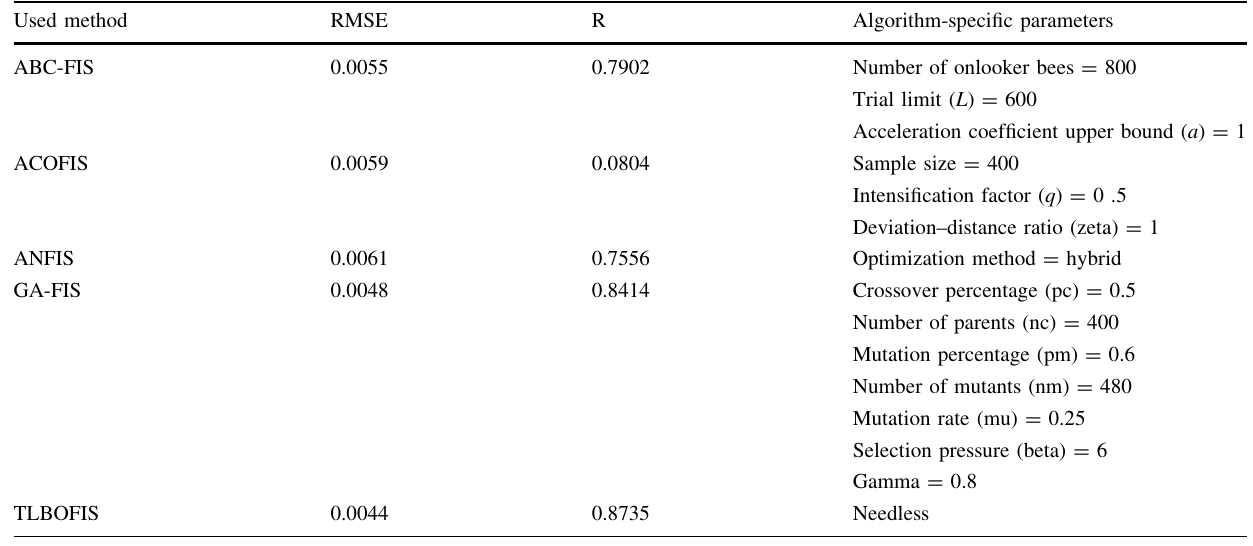
Table 2 Algorithm-specific parameters and the highest accuracy achieved by each method, in test data